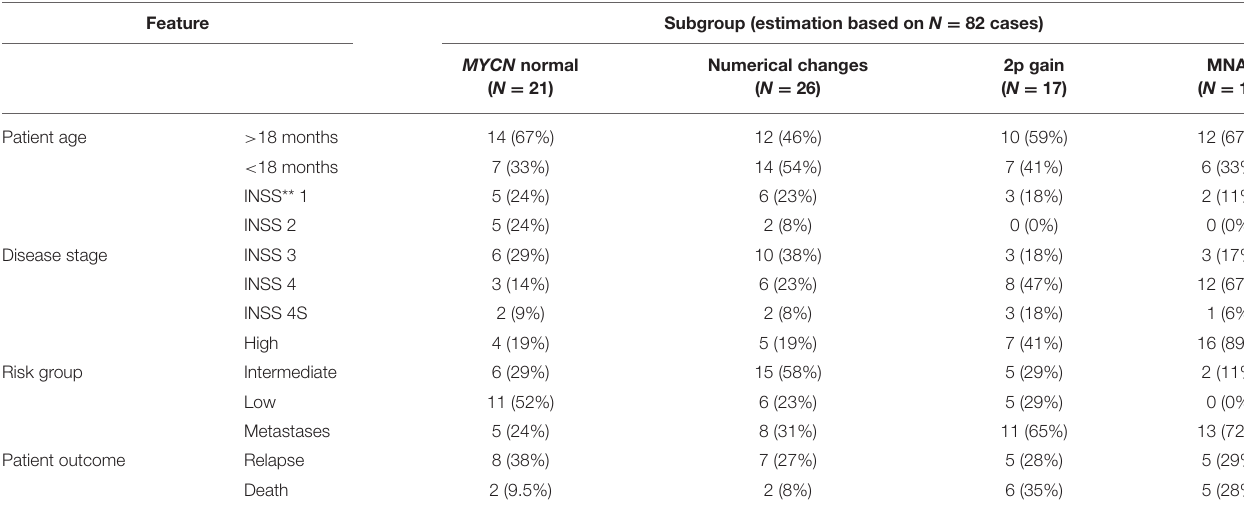
TABLE 1 | Clinical data for the study